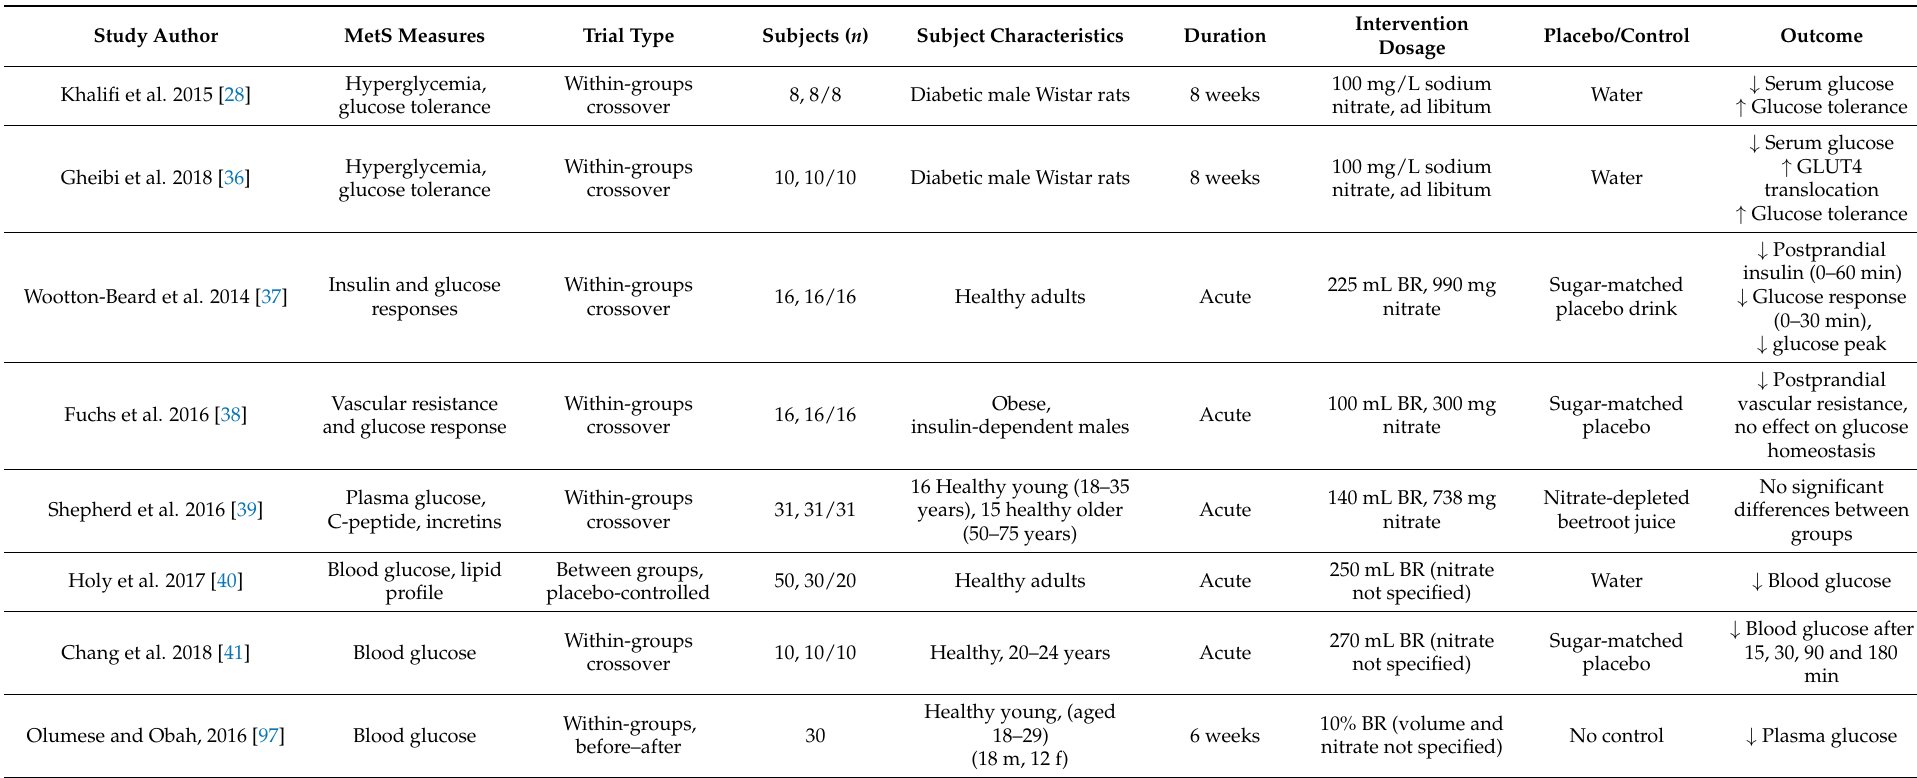
Table 3. Details of beetroot and dietary nitrate studies investigating glucose